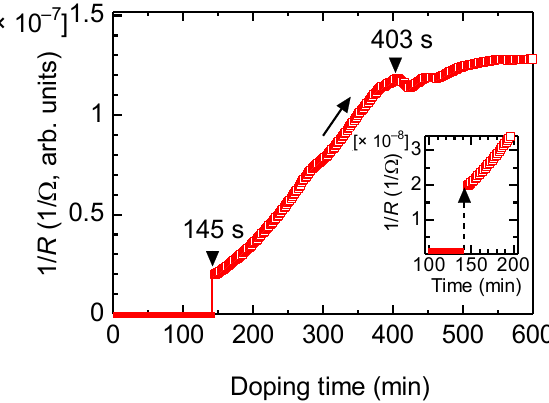
Figure 5. Change in electrical conductivity of PAZ/Hb vs. vapor phase iodine doping.